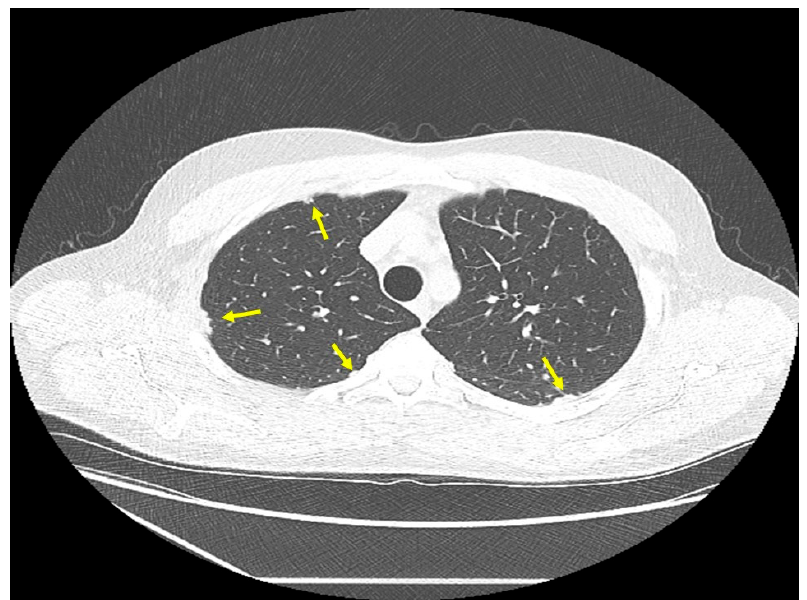
Figure 4. Chest CT image of a patient with pulmonary sarcoidosis, demonstrating subpleural opacities from granulomatous inflammation (arrows).